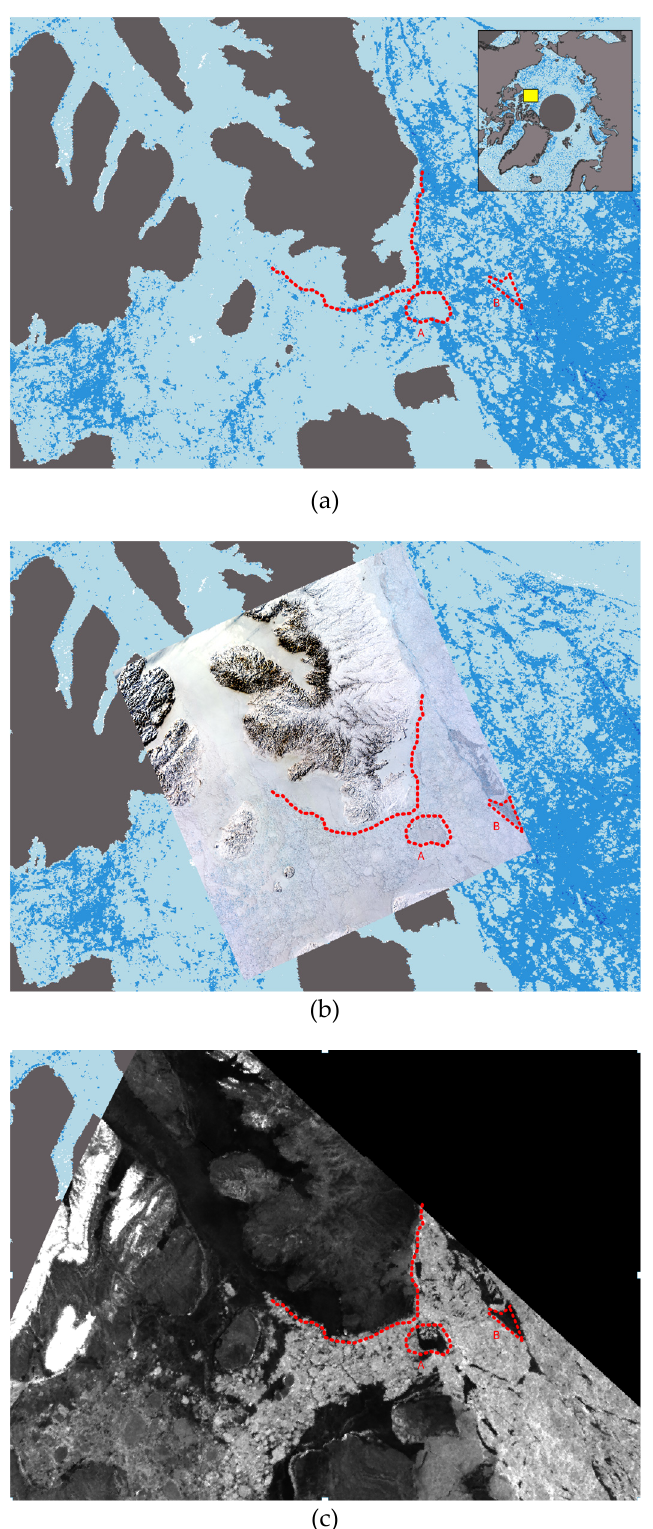
color which represents a mixture of smooth and rough surface patterns. The same pattern can be observed in zone B in the Sentinel-1 image.